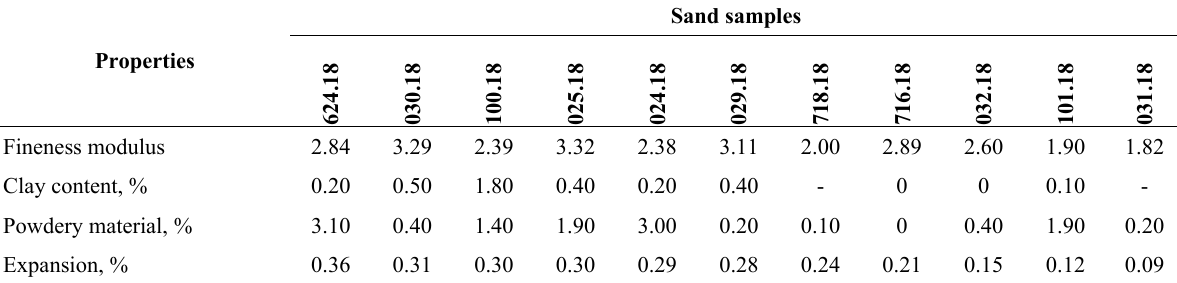
Table 2. Results of the physicochemical and expansion tests of the 11 sand samples evaluated applying the standards [11]–[20].